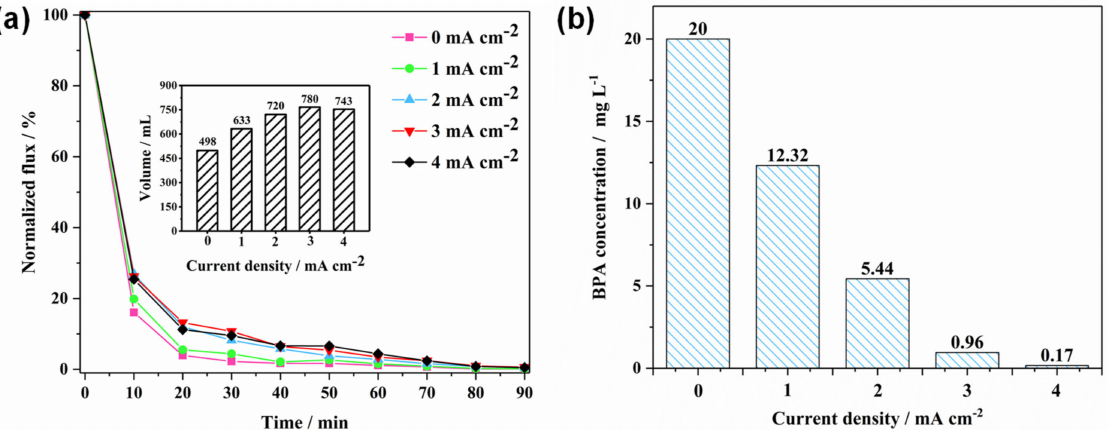
Figure 4. ( a ) Normalized flux of PbO 2 -REM of the antifouling experiment under different current densities and ( b ) BPA concentration after treatment under different current